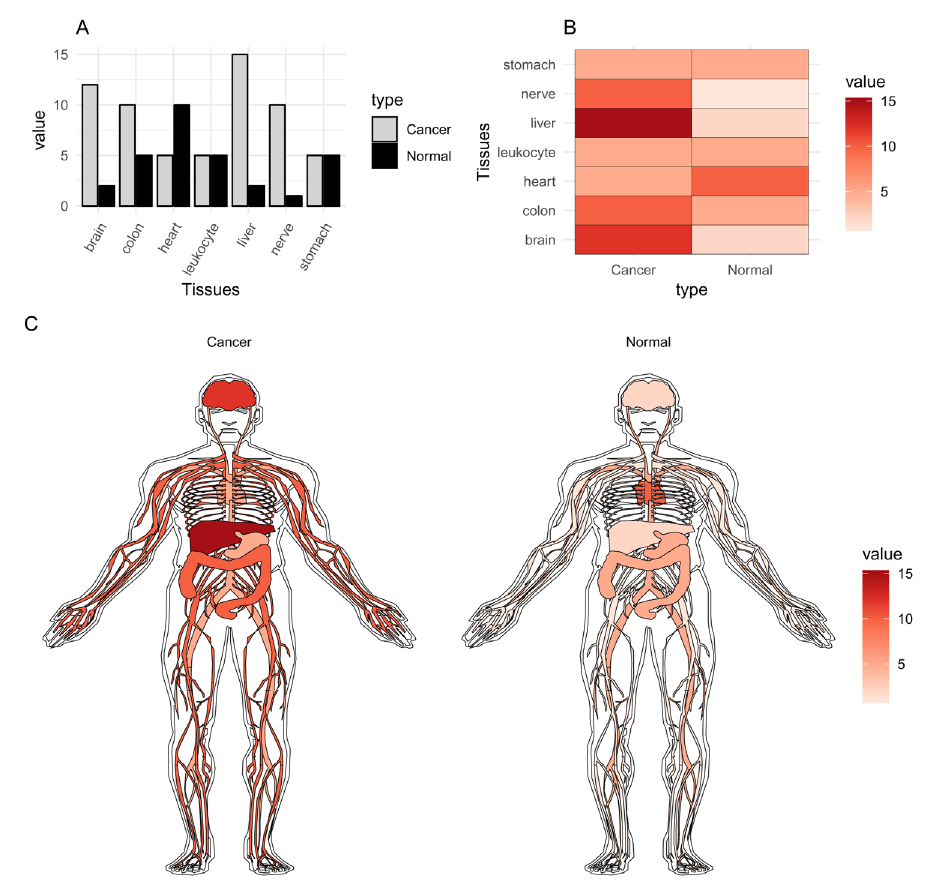
Figure 1. Comparison between barplot (top left), heatmap (top right), and anatogram (bottom) to display tissue values between groups. The values in the graphs are the